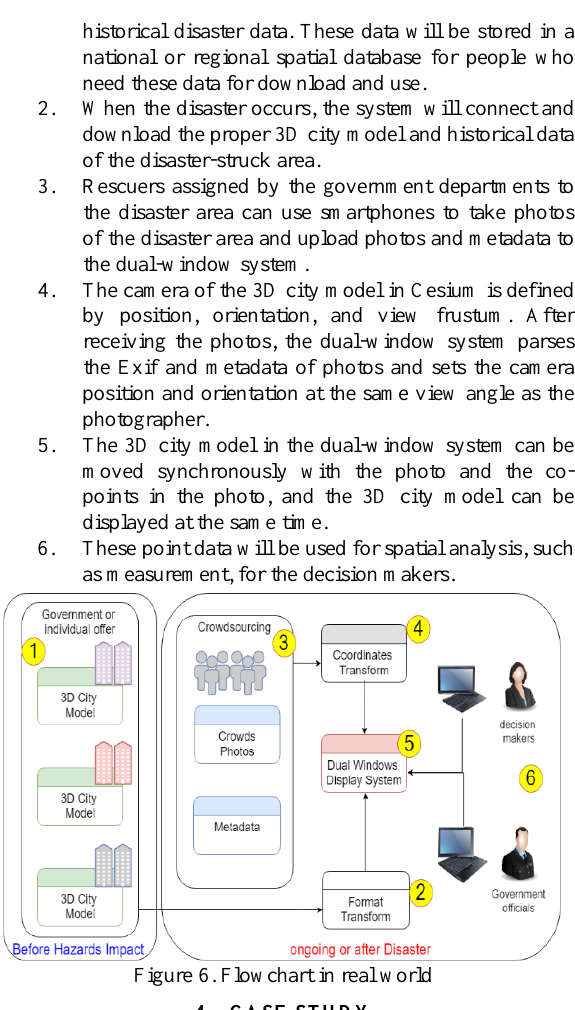
Figure 6. Flowchart in real